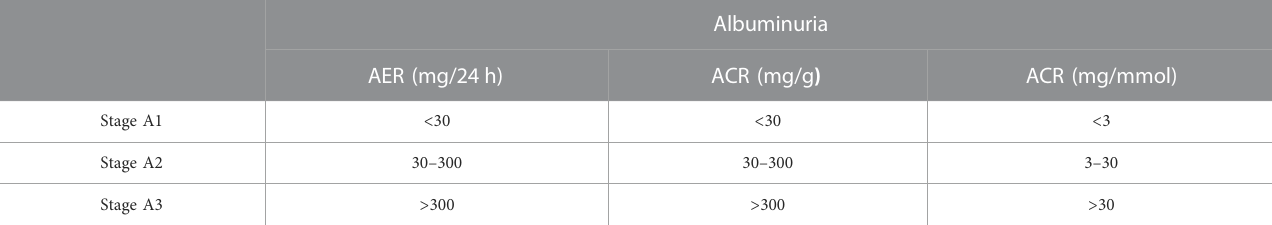
TABLE 2 Classi fi cation of CKD based on albuminuria measured as albumin excretion rate (AER) or albumin-to-creatinine ratio